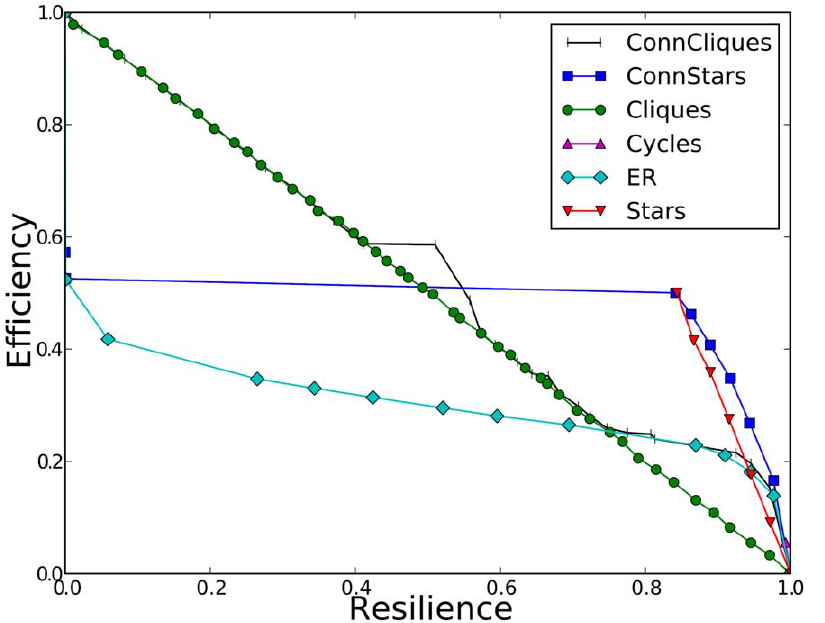
Figure 6. The Pareto frontiers of various network designs ( t ~ 0 : 4 ). The configurations of the Connected Stars design dominate over other designs when the network must achieve high resilience. However, designs based on cliques are dominant when high efficiency is required. Several designs show sharp transitions where at a small sacrifice of efficiency it is possible to achieve large increases in cascade resilience.